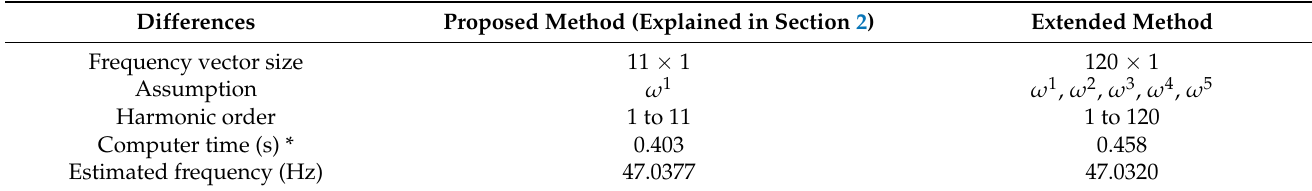
Table 17. Parameters of the proposed method and the extended